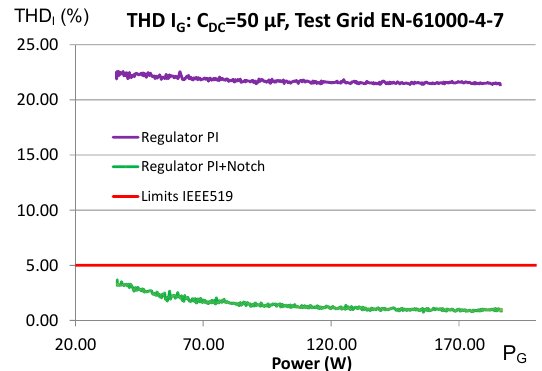
Figure 14. THD of I G . Grid: EN-61000-4-7 (1.2% THDv). Linear sweep of power injected into the grid (P G ) from 40 W to 180 W at grid frequency F G = 50 Hz.